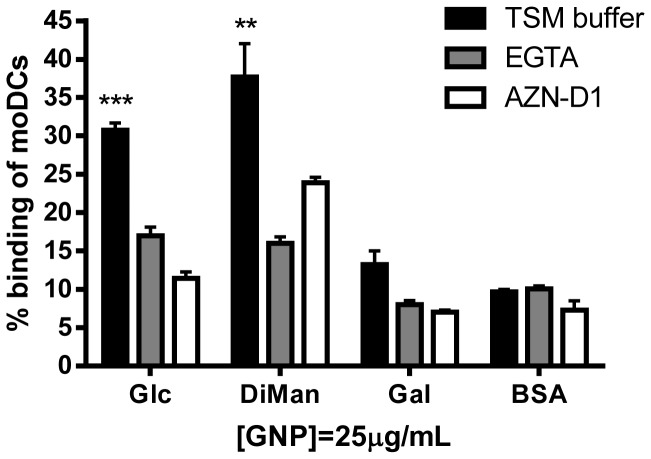
Dendritic cells adhesion assay using GNP-ELISA.Dendritic cells show different carbohydrate-affinity. Binding of moDC to GNPs in calcium and magnesium containing buffer, was determined using plate adhesion assay in the presence or absence of EGTA (3.75 nM) or anti-DC-SIGN antibody AZN-D1 (10 μg/mL). These experiments were performed at least four times with similar results. Each experiment was performed in triplicate. Error bars indicate standard deviations. The binding to the GNPs was significantly decreased when treated with EGTA or AZN-D1, as indicated with one (p<0.05) or two asterisks (p<0.01).